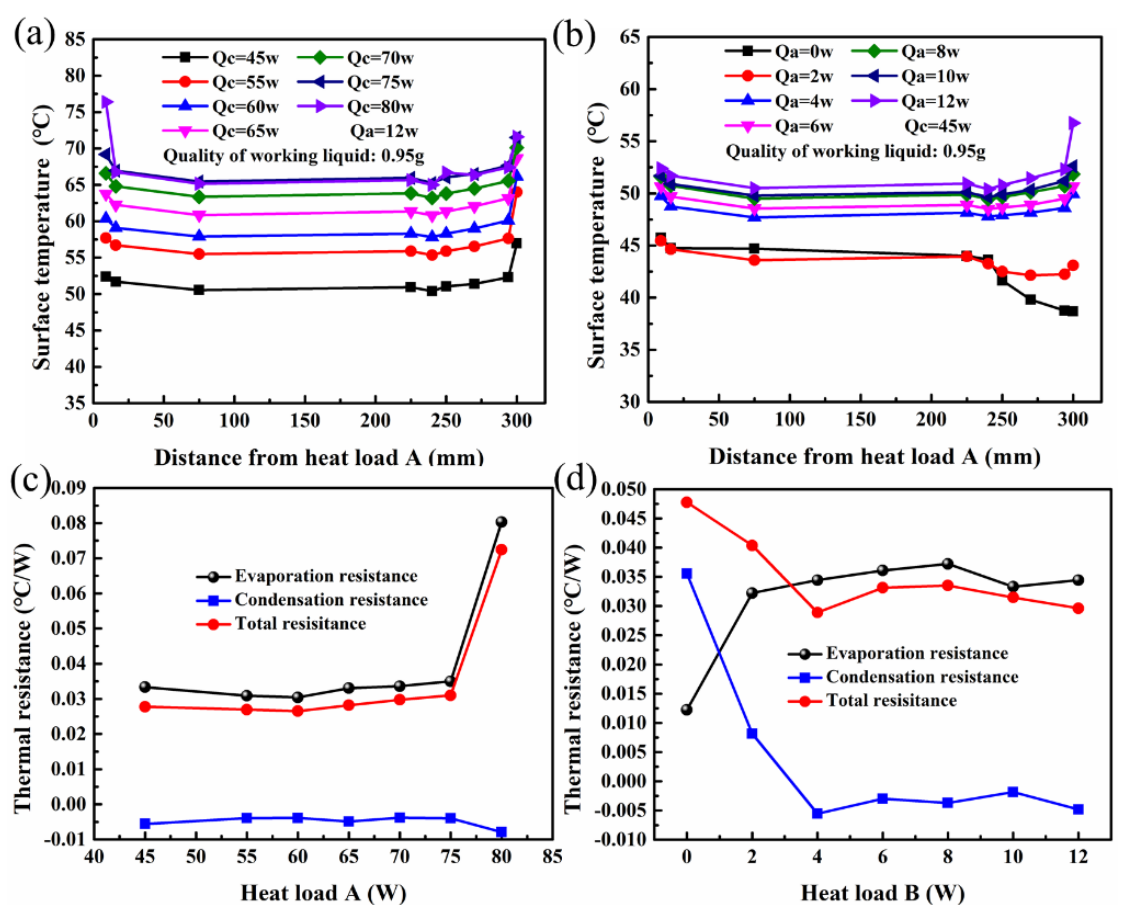
Figure 8. ( a ) The surface temperature distribution of TSHP-1 with different heat load A (named Q c in the figure) from 45 W to 80 W under a certain heat load B input of 12 W; ( b ) the surface temperature distribution of TSHP-1 with different heat load B (named as Q a in the figure) from 0 to 12 W under a certain heat load A input of 45 W; ( c ) the thermal resistance of TSHP-1 with different heat load A from 45 W to 80 W under a certain heat load B input of 12 W; ( d ) the thermal resistance of TSHP − 1 with different heat load B from 0 to 12 W under a certain heat load A input of 45 W.